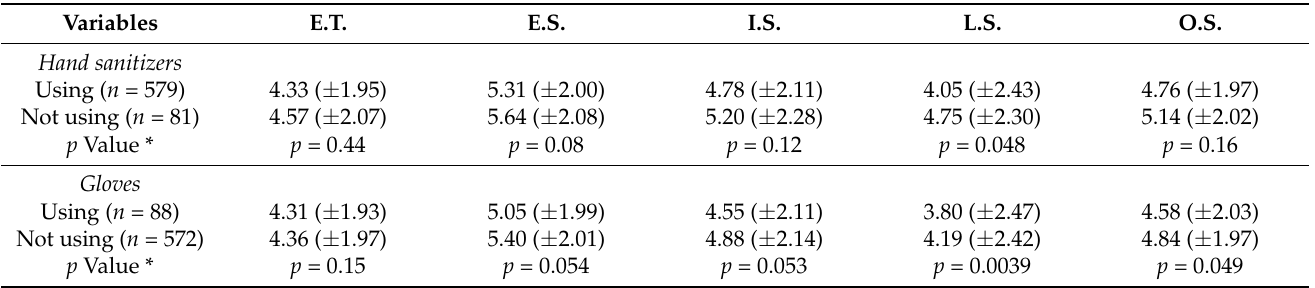
Table 5. Association between usage of hand sanitizers, gloves, and scores obtained on the KPS scale (mean score ± standard deviation).